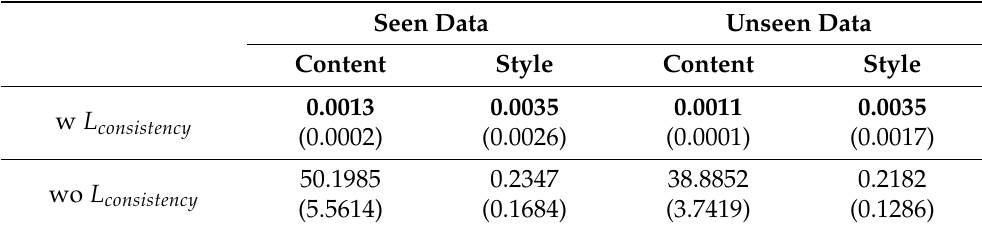
Table 3. Average (and standard deviation) of L2 distances between the encoded features of 16 stacks with or without consistency loss. Bold values indicate the lowest values.